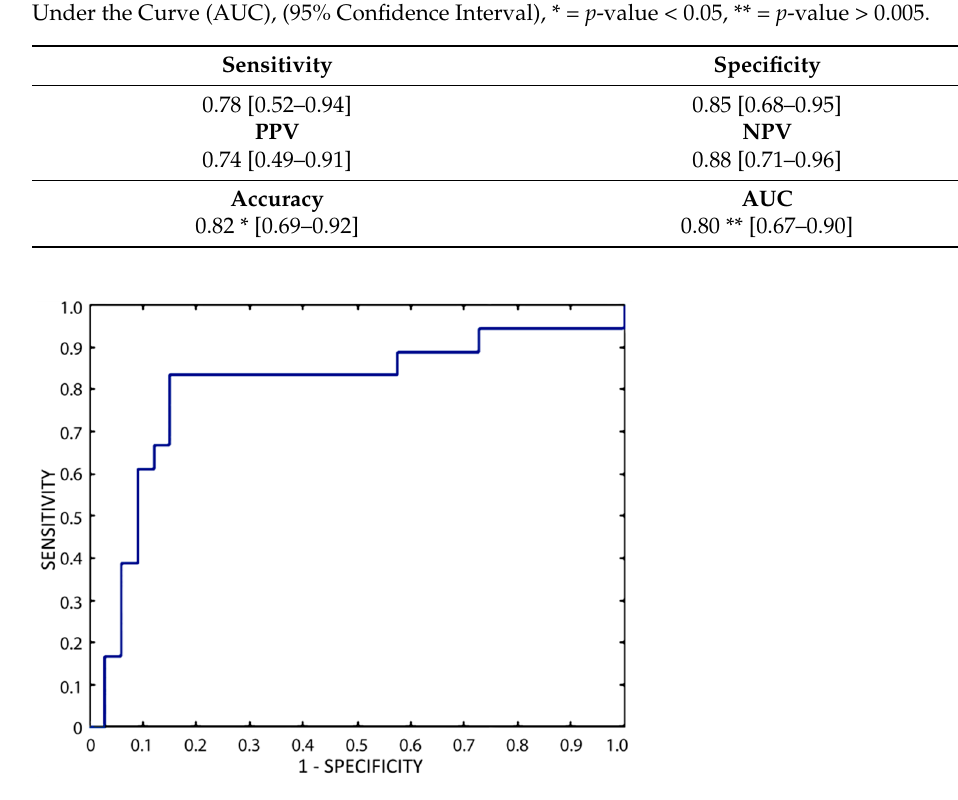
Table 5. Reference standard classification (from DBT-guided VAB and follow-up), and radiomic classification, for each single patient included in the study.